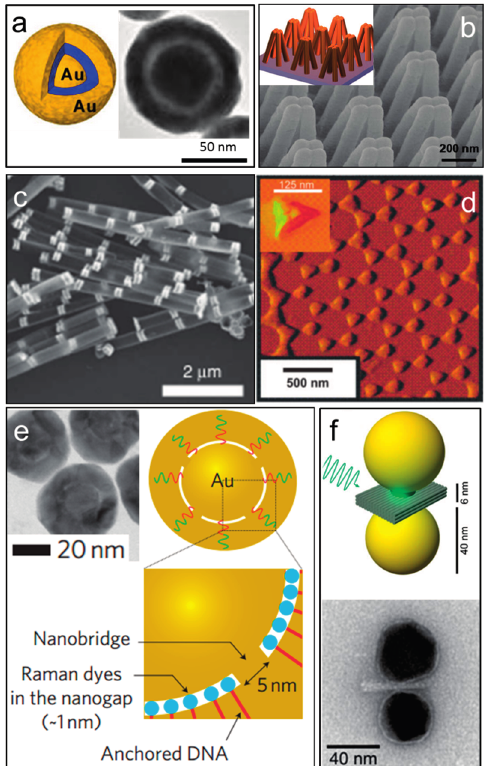
Figure 4. ( a ) Schematic and SEM image of a gold Nanomatryoshka particle, with permission from [41]; ( b ) Schematic and SEM images of gold nanofingers arrays,